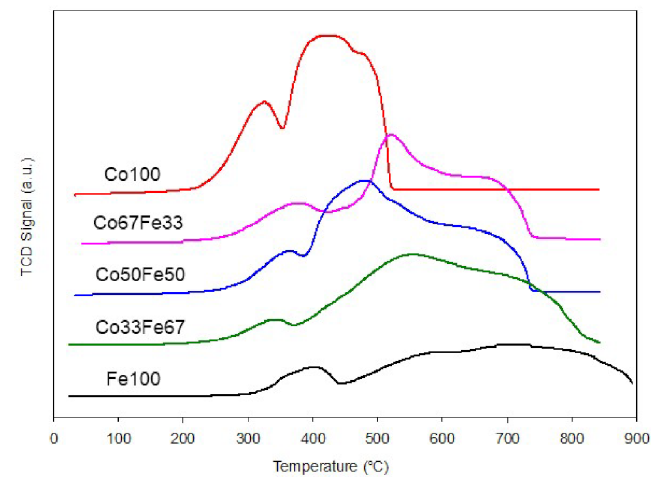
Figure 7. H 2 -TPR profiles of Co-Fe